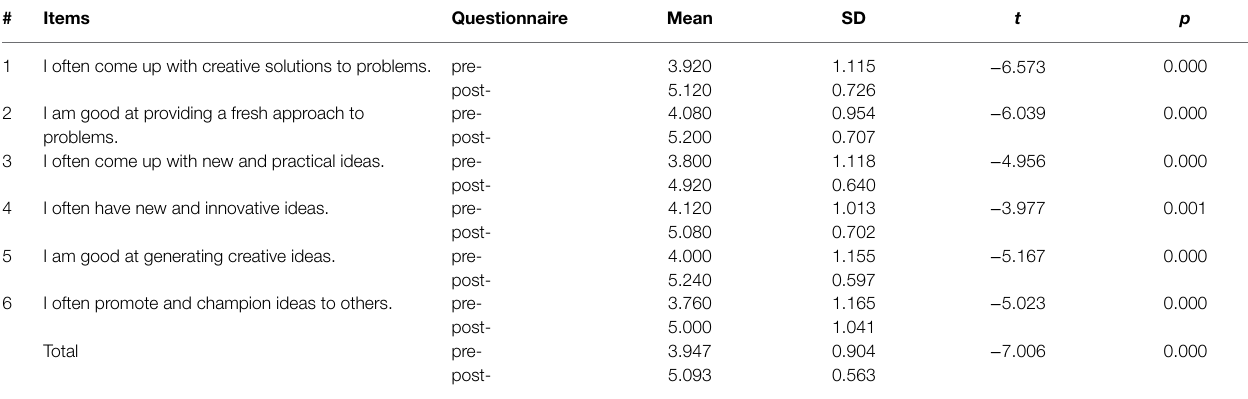
TABLE 1 | Perceived creativity before and after learning